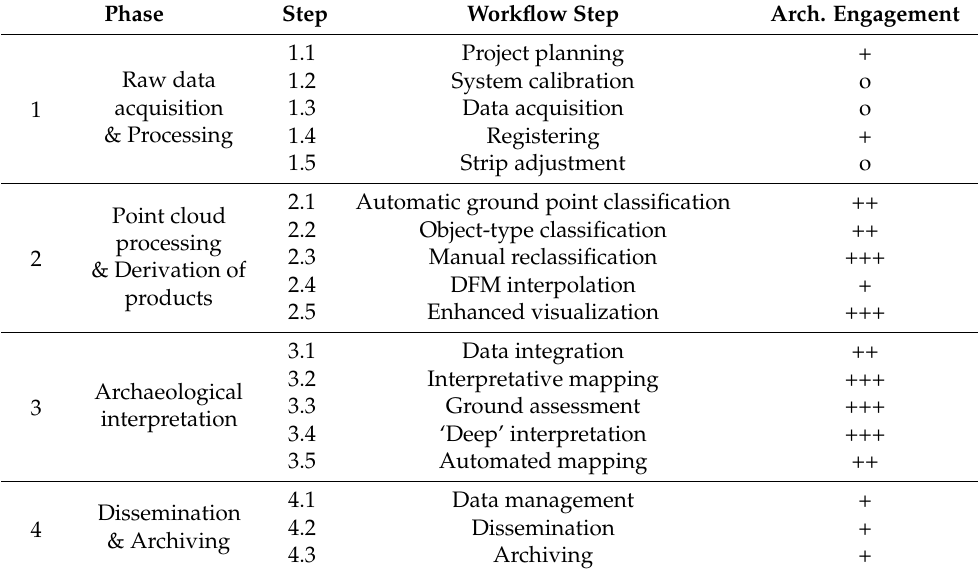
Table 1. Archaeology-specific airborne LiDAR data processing workflow from mission planning to archiving. Arch(aeological) engagement: o nonessential; + as consultant; ++ important; +++ essential. The processing steps that are the subject of this article are in black, and all others are greyed out. (Adopted from [5]: Table 2, published under CC-BY 4.0.). Workflow Step Arch.